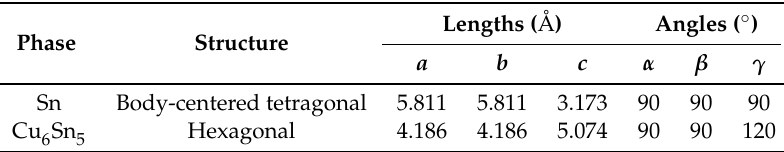
Table 1. Reference lattice parameters and crystal structure used for indexing of the measured diffraction